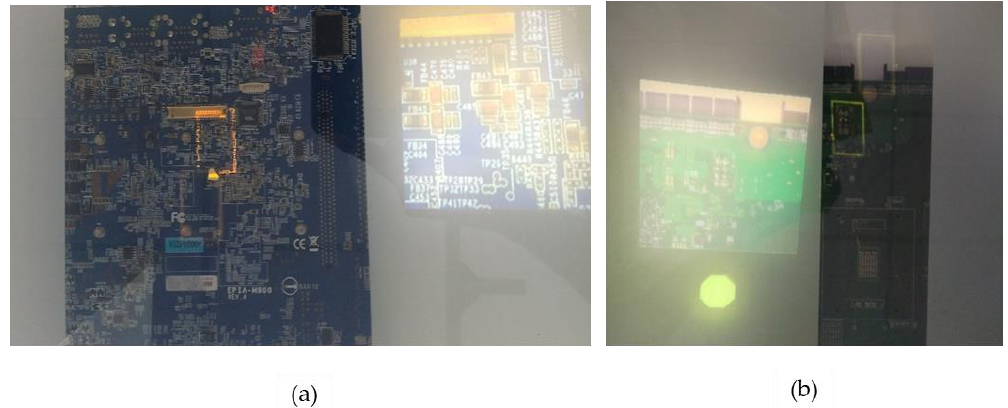
Figure 3. ( a ) Contextualized Reference Image Small Sized PCBA; ( b ) Contextualized Reference Image